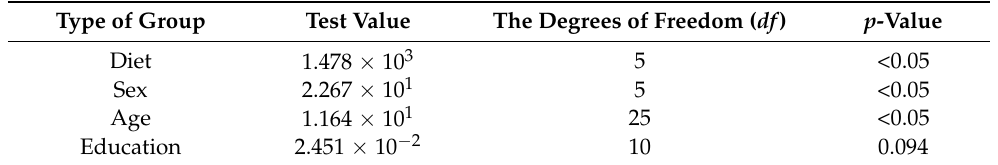
Table 3. Dependence between the covering the RDA for iodine and selected factors (diet; education, sex, age) among people aged 18–80 (chi-square independence